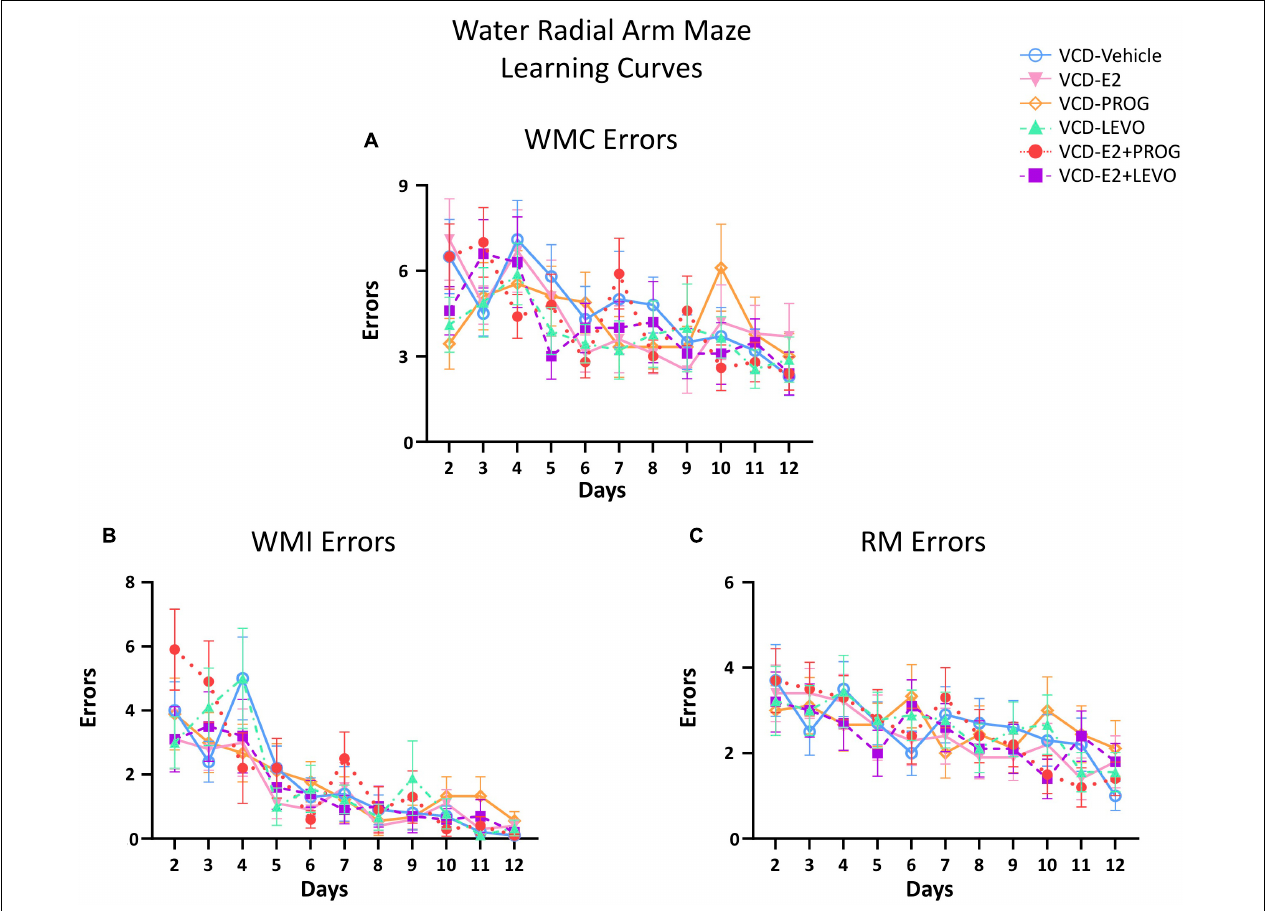
FIGURE 2 | Water Radial Arm Maze Error Subtype Learning Curves. (A) Working memory correct errors across days (B) Working memory incorrect errors across days (C) Reference memory errors across days. For all error types, Day 1 was considered Training and was excluded from data analysis. The Early Acquisition Phase was defined as Days 2–5, the Late Acquisition Phase was defined as Days 6–9, and the Asymptotic Phase was defined as Days 10–12. Performance for each error subtype was analyzed separately. The n/group for all WRAM two-group analyses were: VCD-Vehicle n = 10, VCD-E2 n = 10, VCD-PROG n = 9, VCD-LEVO n = 9, VCD-E2 + PROG n = 10, and VCD-E2 + LEVO n =